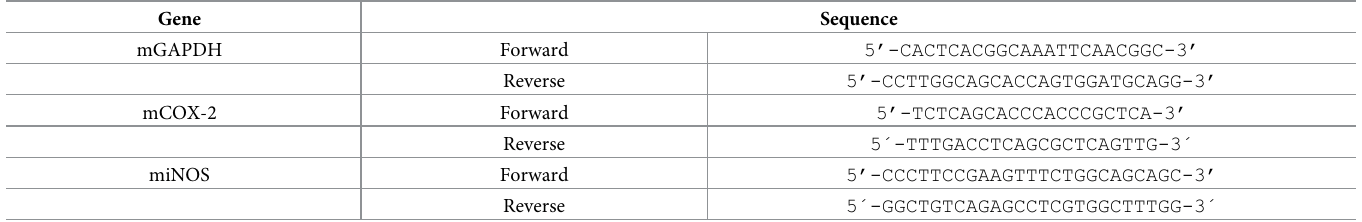
Table 2. Primer sequences for qRT-PCR quantification of inflammatory mediators.